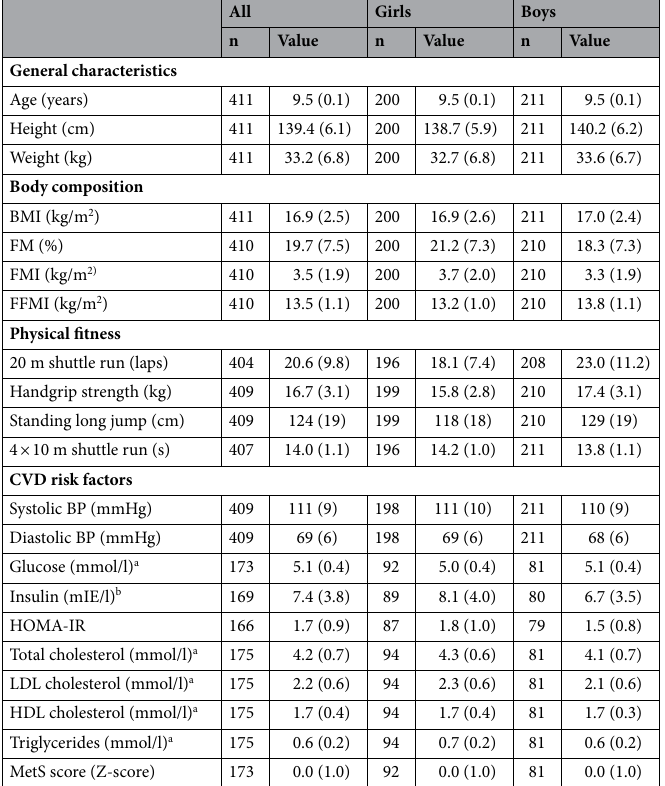
Table 1. Descriptive characteristics of the 9-year-old children. Values are presented as means (standard deviations). BMI, body mass index; BP, blood pressure; FM, fat-mass; FMI, fat-mass index; FFMI, fat-free mass index; CVD risk factors, cardiovascular disease risk factors; HDL, high density lipoprotein cholesterol; LDL, low density lipoprotein cholesterol; HOMA-IR, Homeostatic Model Assessment of Insulin Resistance; MetS score, metabolic syndrome score calculated using normalized sum of sex-specific z-scores for triglycerides, inverted (by multiplying with − 1), HDL-cholesterol, fasting glucose and the average of systolic and diastolic blood pressure. a Measured in plasma. b Measured in